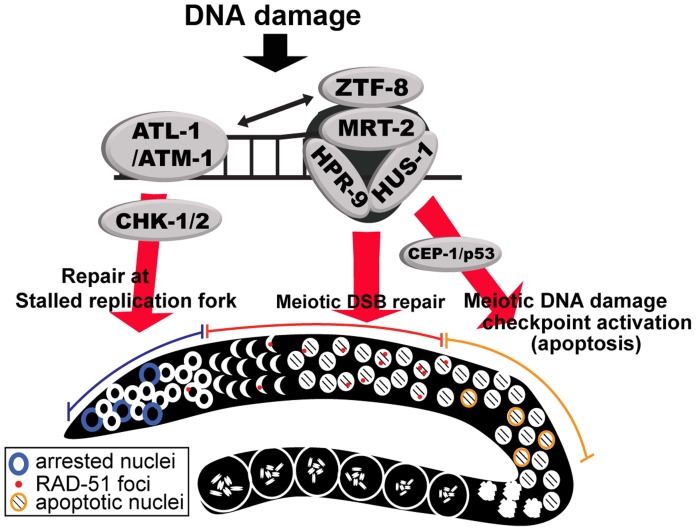
Model for the role of ZTF-8 in DNA damage response and repair.DNA damage induces DNA replication arrest and DSB repair in the germline. First, stalled replication forks in mitotic dividing cells induce the S-phase cell cycle checkpoint via activation of the ATL-1- and CHK-1-dependent pathway. Second, programmed meiotic DSBs will be repaired by homologous recombination, whereas persistent unrepaired DSBs and/or aberrant recombination intermediates will be removed by apoptosis via activation of the CEP-1/p53-mediated DNA damage checkpoint. ZTF-8 participates both in the activation of the DNA damage checkpoint and in DSBR. We propose that ZTF-8 acts via the 9-1-1 complex in transducing DNA damage signaling for repair of both mitotic and meiotic DSBs and meiotic germ cell apoptosis.